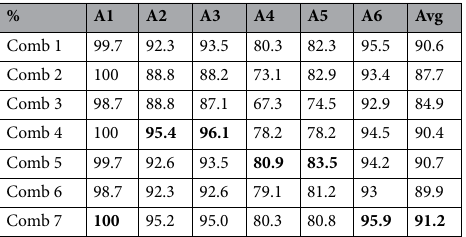
Table 11. Classification results for the different combinations of data domains without feature fusion.